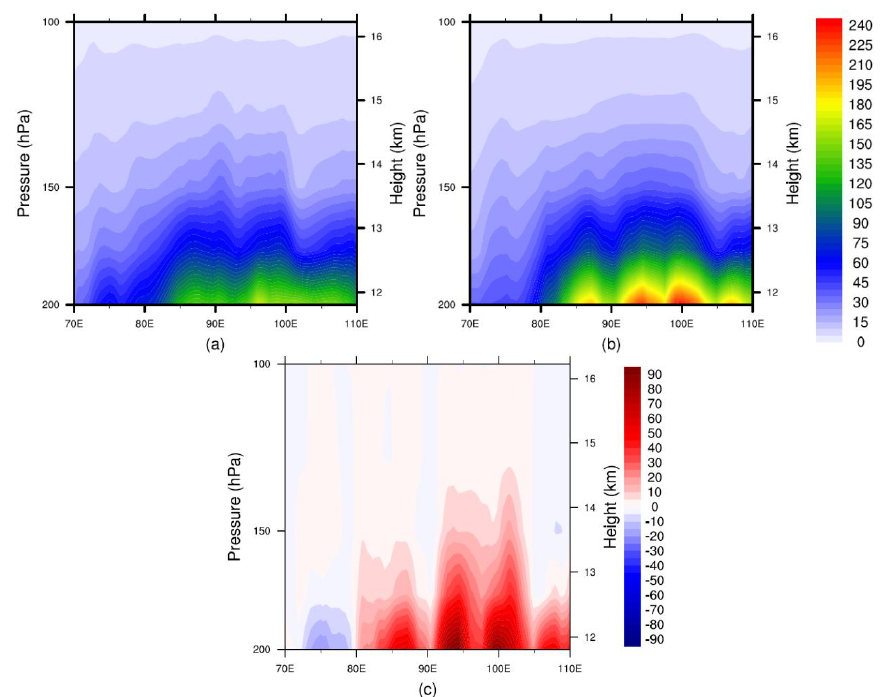
Figure 7. Vertical distribution of specific humidity (units: 10 −6 kg·kg −1 ), averaged between 31°N and 35°N at 06UTC ( a ) and 18UTC ( b ). ( c ) Variation in specific humidity (units: 10 −6 ·kg·kg −1 ) from 18 UTC (after the precipitation) to 06 UTC (before the precipitation).